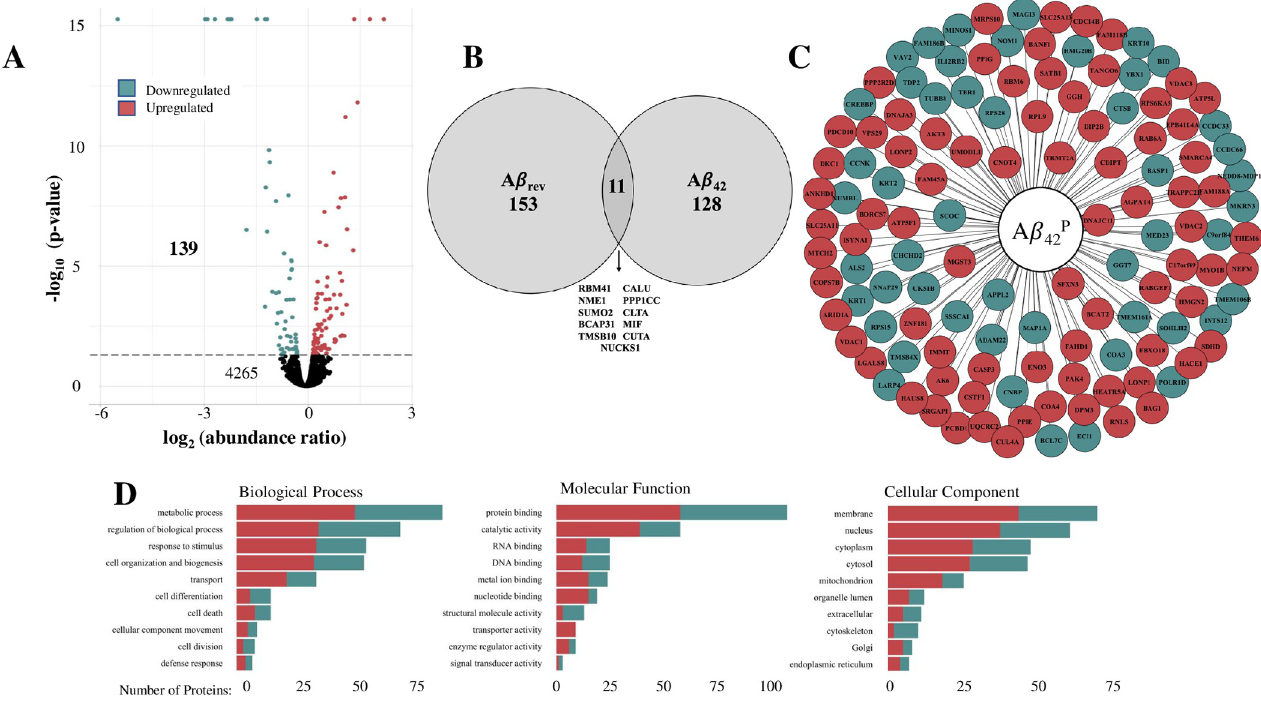
Fig 2. Proteome response to A β 42 treatment. A) The distribution and number of detected proteins within samples of A β 42 treated cells. The horizontal line indicates the threshold for statistical significance (p < 0.05). B) Proteins altered by A β 42 and A β rev . C) Components of the A β 42P identified by their gene symbols. D) The number of proteins within the A β 42P associated with GO